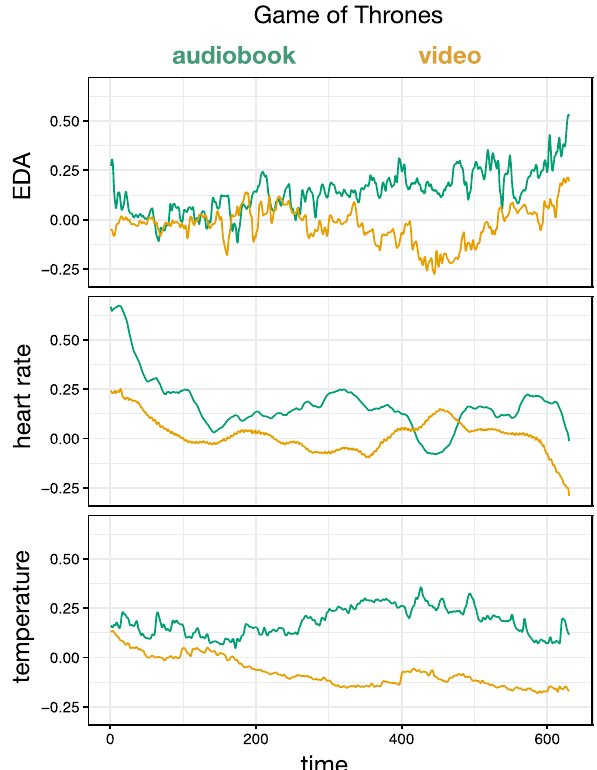
Figure 1. Time-course of physiological measures during the Game of Thrones story in two